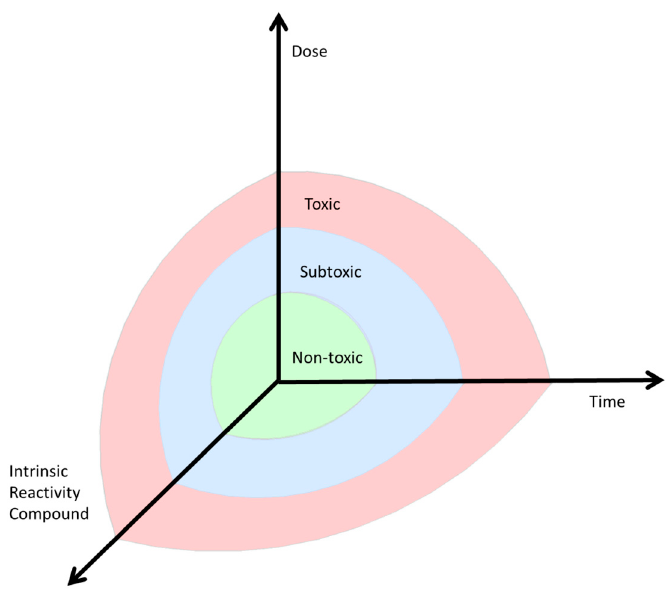
Figure 1. The dose, the compound involved, and the timing of exposure influence whether homeostasis exists (green = normal ≠ safe, but adapted to toxicity, as low as reasonably achievable (ALARA)), an adaptive response (blue, subtoxic) or toxicity (red, toxic) is induced.